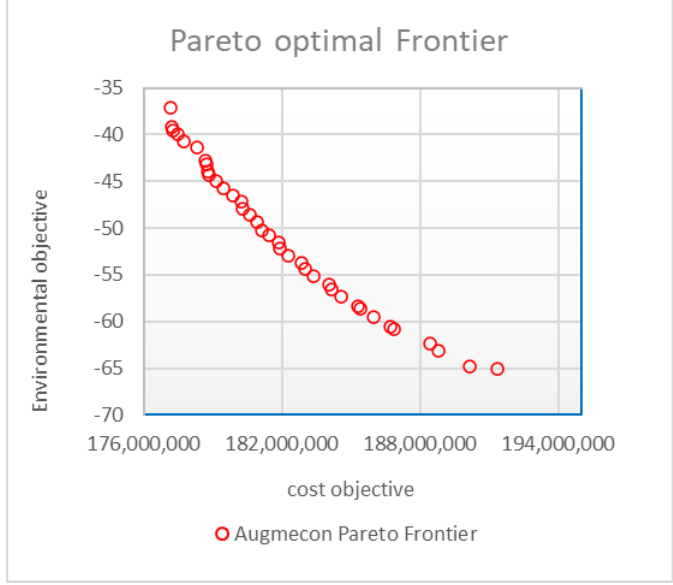
Figure 1. Pareto optimal frontier of AUGMECON.